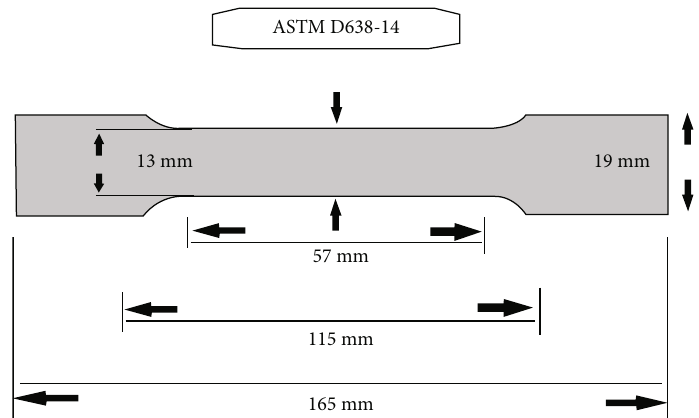
Figure 3: Geometry and dimensions of the dog bone specimens which have been used in tension test based on the ASTM D638-14 [14].